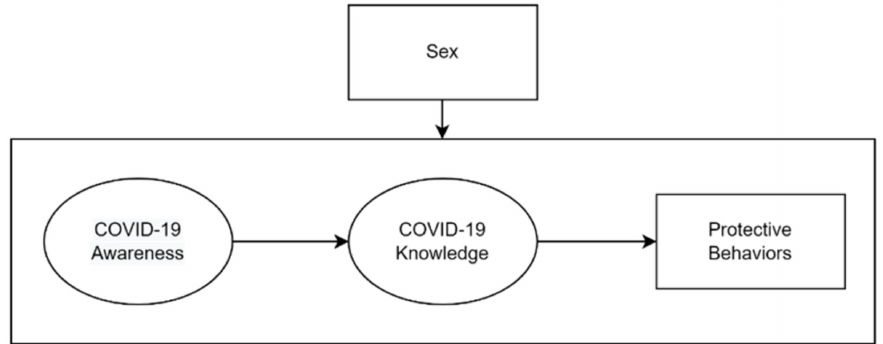
Figure 1. The hypothesized model of this